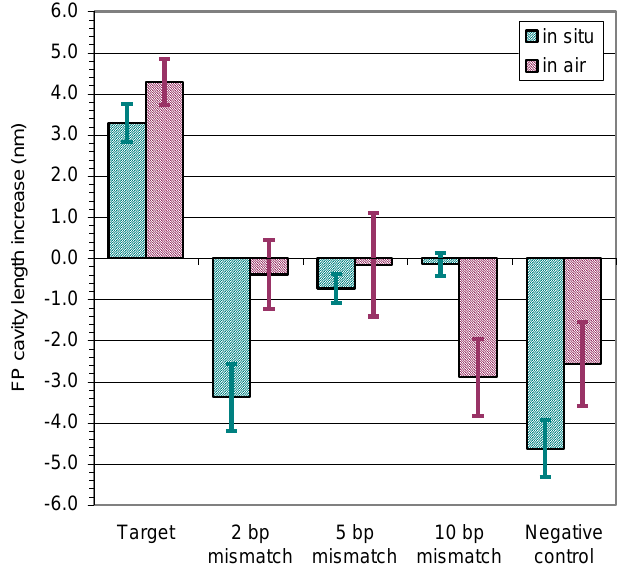
Figure 7. Detection of hybridization of 26-mer target to immobilized probe. Probe: 26-mer ssDNA-A immobilized on FFPI sensor tip; target: ssDNA-B, 53  M; 2 bp mismatch: ssDNA-C, 138  M; 5 bp mismatch: ssDNA-D, 152  M; 10 bp mismatch: ssDNA-E, 145  M; and negative control: 22-mer random ssDNA-F, 128  M. A positive slope between probe immobilization and target detection indicates a positive